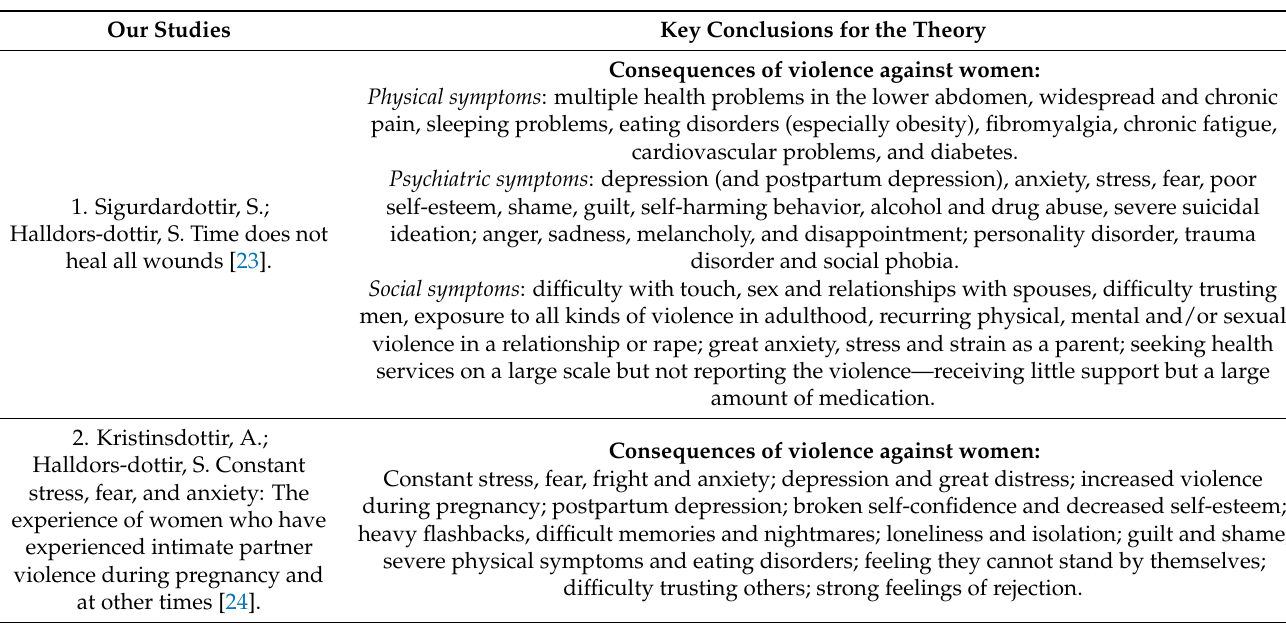
Table 2. The seven published studies used in Step 1 of the theory